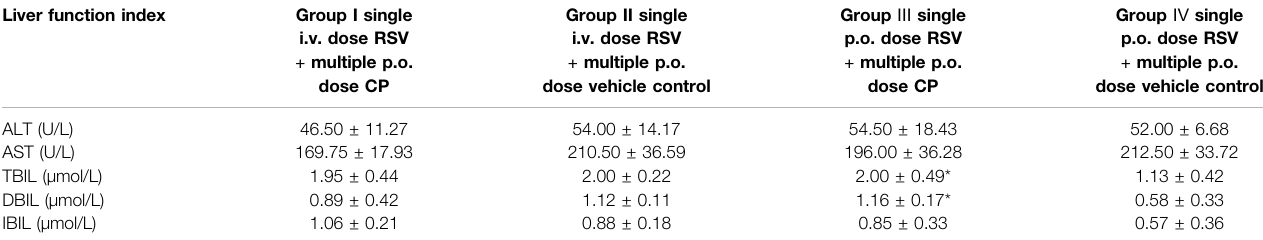
TABLE 2 | Liver function indices of rats. Data are mean ± S.D. (n (cid:2) 4). * p < 0.05 when compared with the respective single dose RSV group. Liver function index